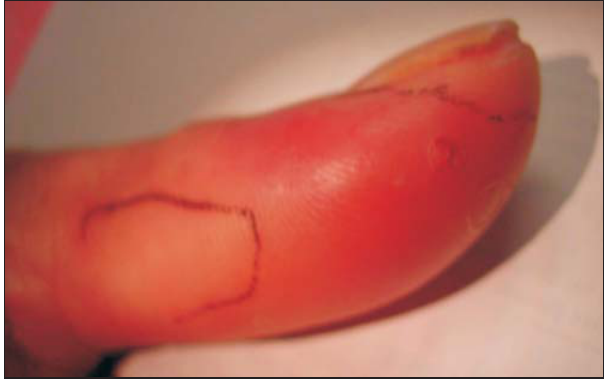
Figure 1) Erythematous thumb with margins demarcated and open puncture